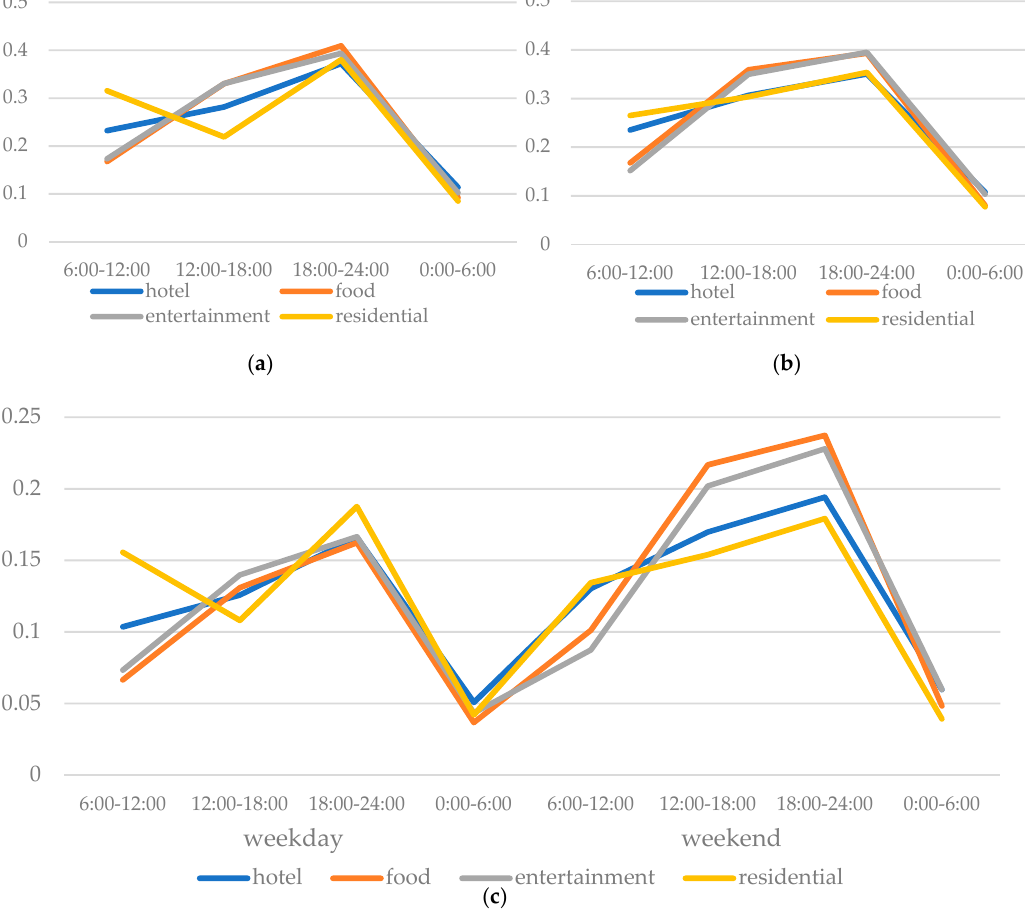
Figure 9. Distribution of check-ins among di ff erent time periods: ( a ) represents the temporal distribution of check-ins on weekdays; ( b ) represents the temporal distribution of check-ins on weekends; ( c ) denotes the distribution of check-ins among eight time periods (e.g., weekday 6:00–12:00, weekend 6:00–12:00).